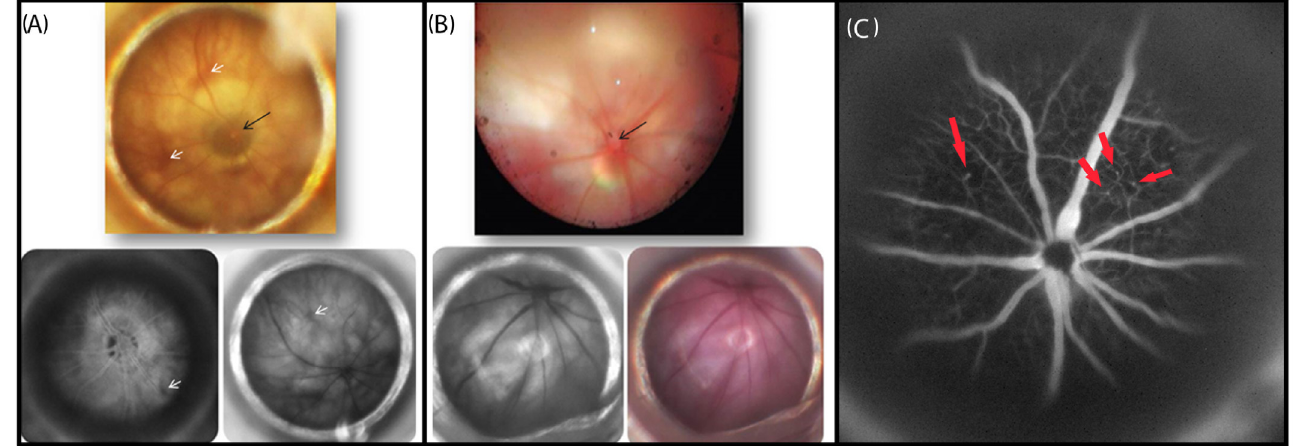
Figure 2. Color fundus photography and red-free and fluorescein angiography. ( A ) DMT1-NOD mice. ( B ) Control mice. The optic nerve head is indicated by a black arrow. White arrows indicate suspected leakages on angiography. The control non-diabetic eyes show normal retinal vasculature. Fluorescein angiography. ( C ) DMT2-db/db mice. Hyperfluorescent areas (red arrows) suggest focal vascular leakage.